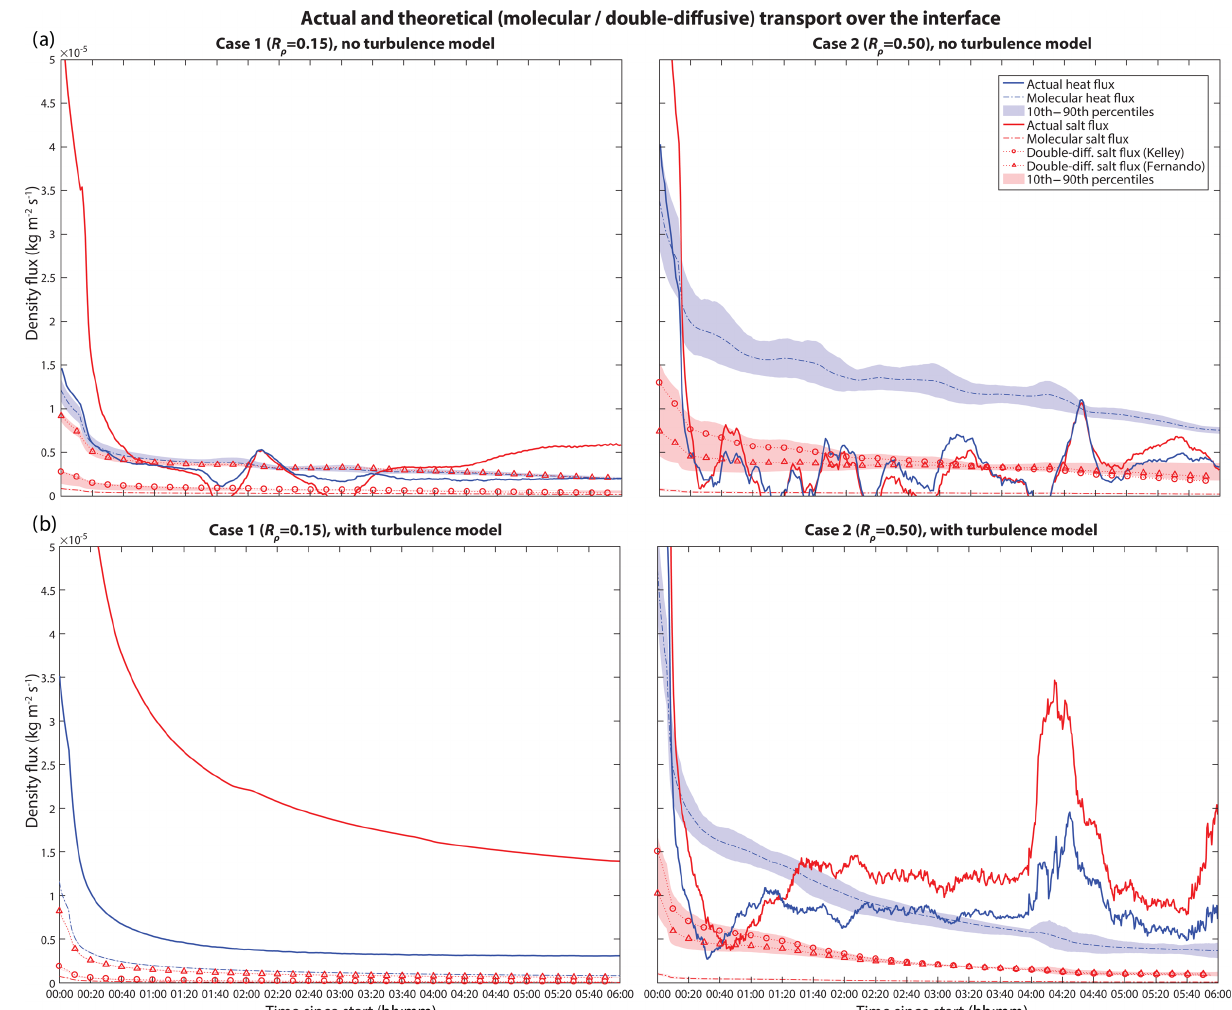
Figure 9. Time evolution of the salt (red) and temperature fluxes (blue) over the interface for R ρ (Case 2, right) and for (a) the simulations without a turbulence model and (b) the simulations with a turbulence model. The fluxes represent horizontal averages throughout the complete domain. The figures also present theoretical fluxes over the interface, which were calculated from molecular and double-diffusive diffusivities, and their uncertainty bounds for horizontal variations in density gradients at the